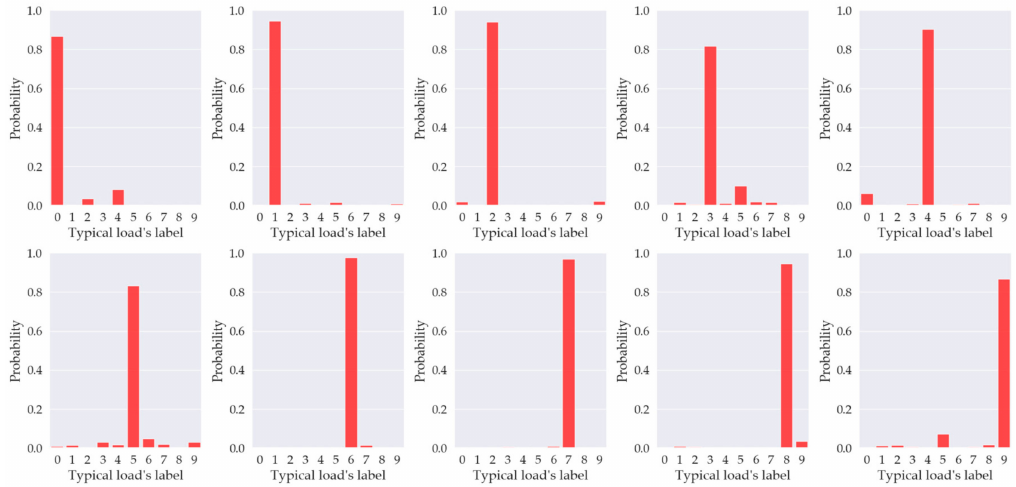
Figure 12. Distribution of probabilities of the di ff erent load types.